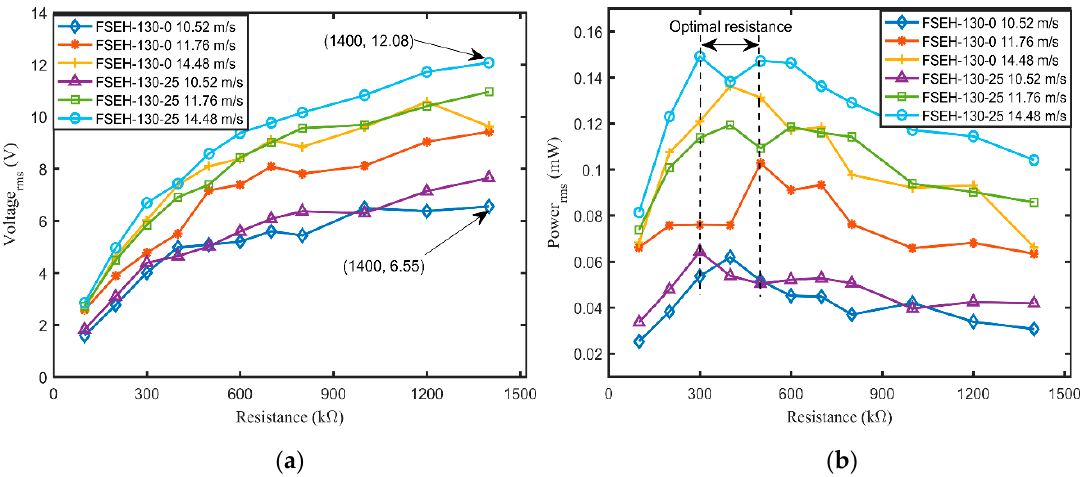
Figure 13. Variation of output voltage and power of the harvester with the external load resistance at 10.52, 11.76, and 14.48 m/s: ( a ) output voltage; and ( b ) output power.